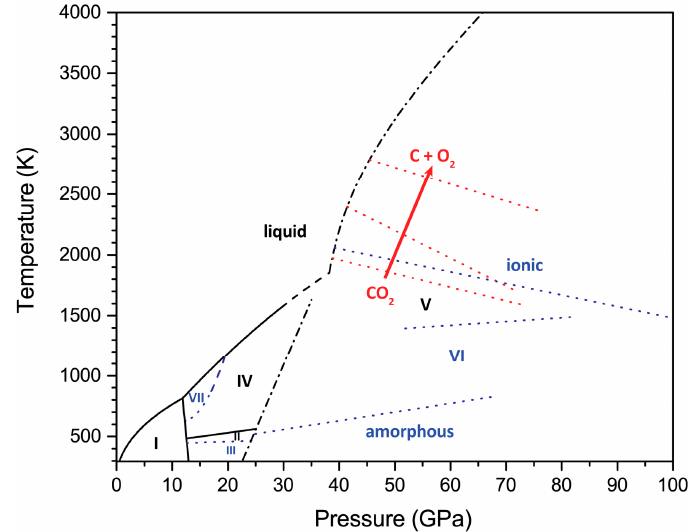
Figure 4. The P – T diagram of carbon dioxide compiled from literature data. Black solid lines represent the phase boundaries of thermodynamically stable phases delineating the stability range of CO 2 -I and the melting curves of molecular phases [58,59], as well as the coexistence line between CO 2 -II and CO 2 -IV [60]. The black dashed line is the extrapolated CO 2 -IV melting curve. Black dash-dotted lines correspond to the computed boundary line between molecular phases and CO 2 -V [61] and the calculated CO 2 -V melting curve [62], used in the absence of reliable experimental data. Metastable states are highlighted in blue: CO 2 -III is most probably a metastable manifestation of CO 2 -VII, and both have the same structure [61], while CO 2 -V appears to be the only thermodynamically stable crystal phase of carbon dioxide above ~35 GPa [53,54,61,63]. Blue dotted traces are the kinetic transition lines involving the metastable states: between CO 2 -IV and CO 2 -VII (the extrapolation indicated by the dashed line) [59], between CO 2 -II and CO 2 -III [51], between amorphous CO 2 and CO 2 -VI [51], between CO 2 -V and CO 2 -VI [51], and between CO 2 -V and ionic i -CO 2 [52]. Red dotted lines denote the thresholds of the dissociation of CO 2 into chemical elements (indicated by an arrow), which was reported in three independent studies [55–57]. This reaction, however, was not confirmed by the subsequent in situ HP – HT study [54].